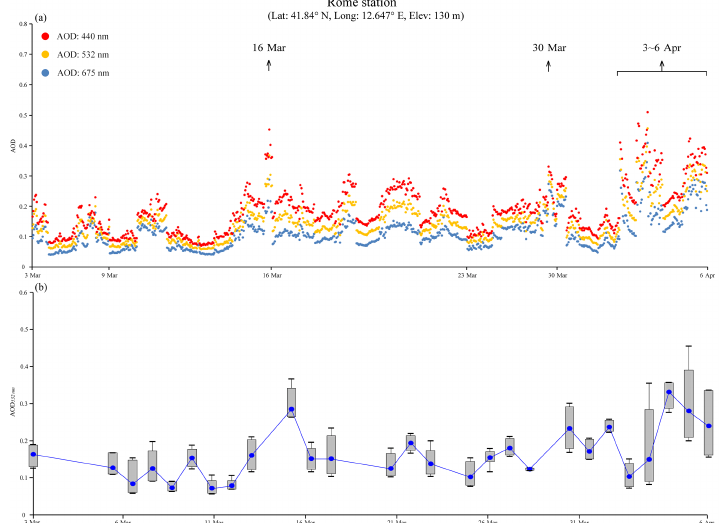
Figure 9. Time series of AOD at the Rome station of AERONET from 3 March to 6 April 2009. (a) AOD at 440, 532, and 675nm; (b) daily average and maximum and minimum values of AOD 532nm , as well as the 5th and 95th percentile box